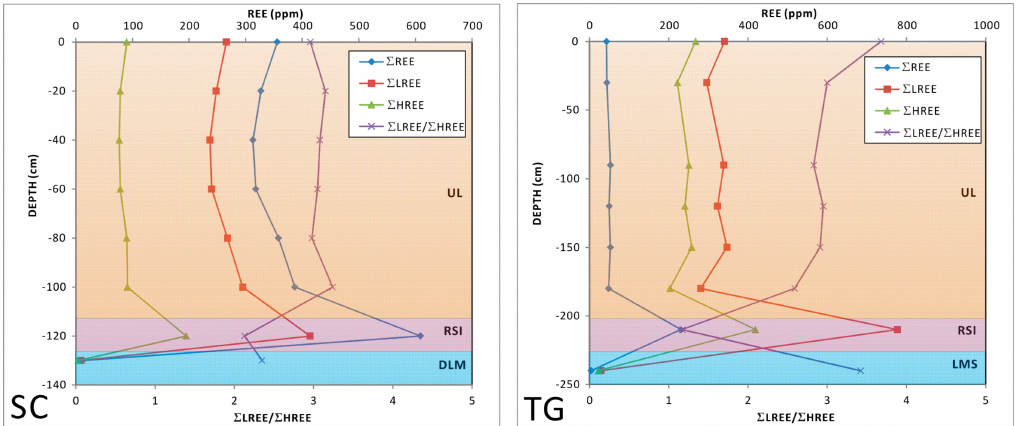
Figure 2. Variation curve of Σ REE (the sum of REEs), Σ LREE (the sum of light REE from La to Eu), Σ HREE (the sum of heavy REE from Gd to Lu and Y), and the ratios of Σ LREE / Σ HREE with depth in SC and TG profiles. UL, RSI, DLM, and LMS denote upper layer, rock–soil interface, dolomite, and limestone, respectively. LREE and HREE denote the light REE and heavy REE as illustrated in Table